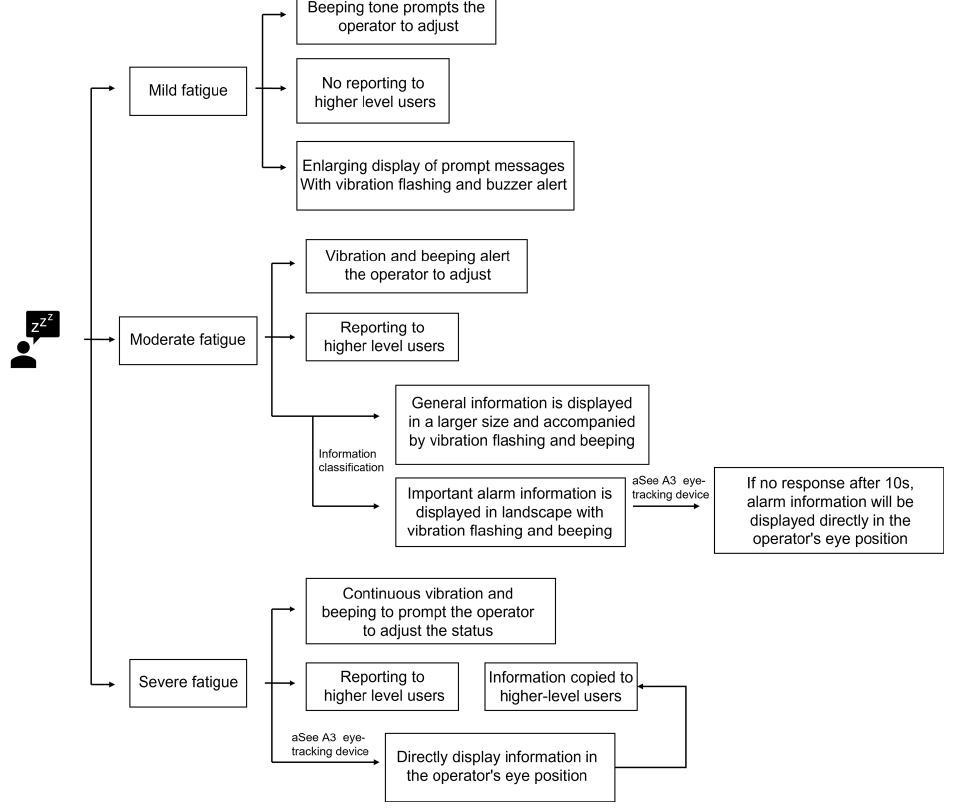
Figure 7. Enhanced feedback schematic.